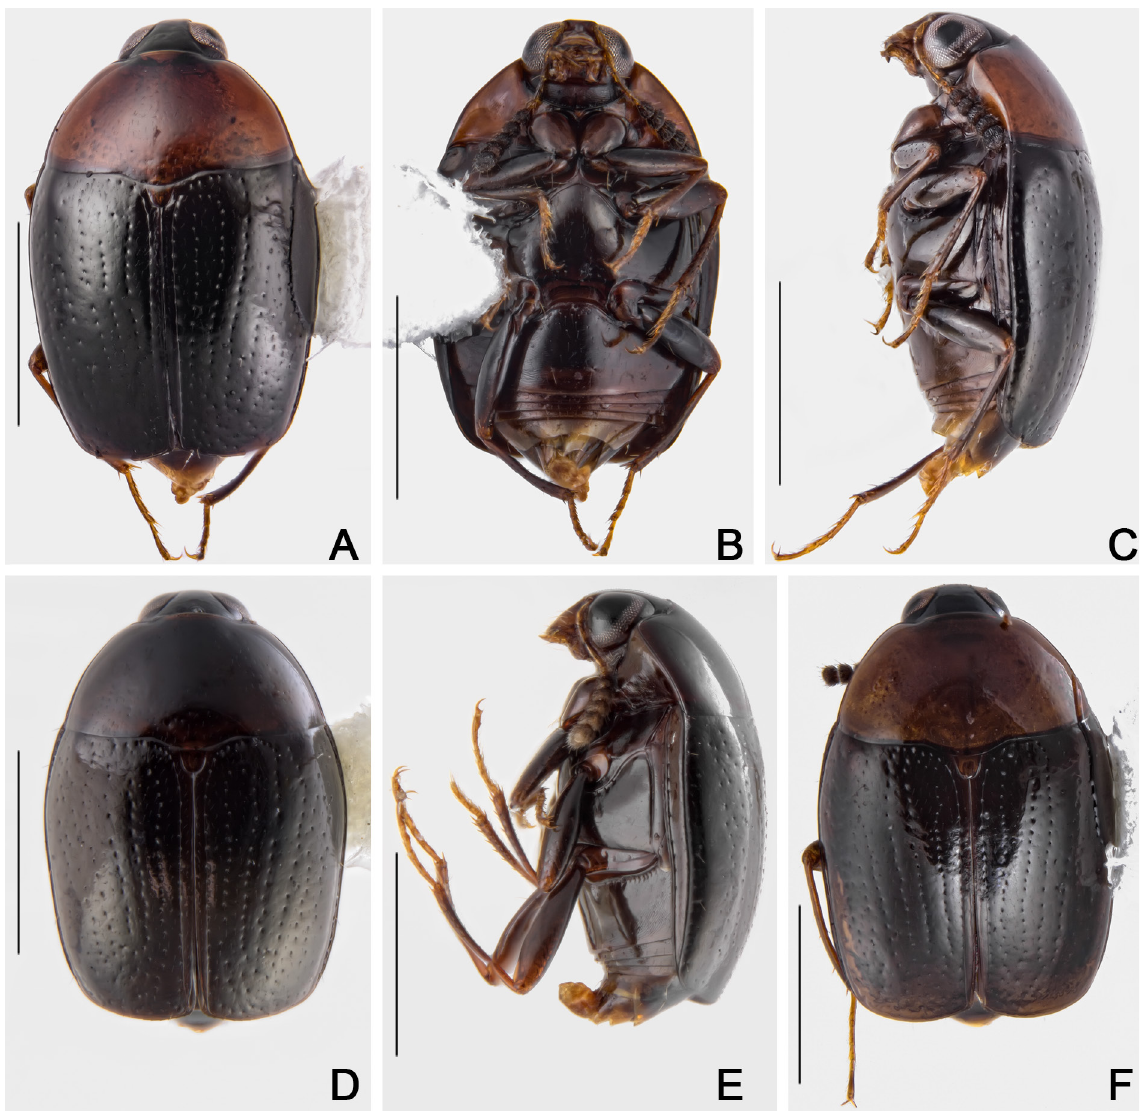
Fig. 30. Cyparium newtoni sp. nov. A–C . Holotype, ♂ (CELC). A . Dorsal view. B . Ventral view. C . Lateral view. D–E . Paratype, unknown sex (CELC). D . Dorsal view. E . Lateral view. F . Paratype, ♀ (CELC), dorsal view. Specimens collected at Mata do Paraíso (A–C) and Mata da Biologia (D–F), Viçosa (MG, Brazil). Scale bars = 1.0